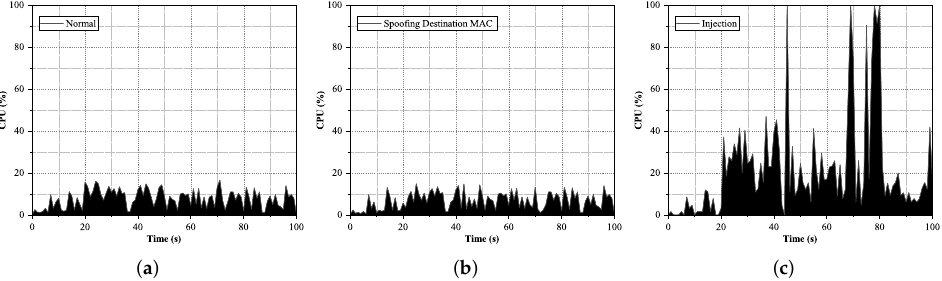
Figure 5. Attack impact on controller CPU usage. ( a ) Normal. ( b ) Spoofing Destination MAC. ( c ) Injection.